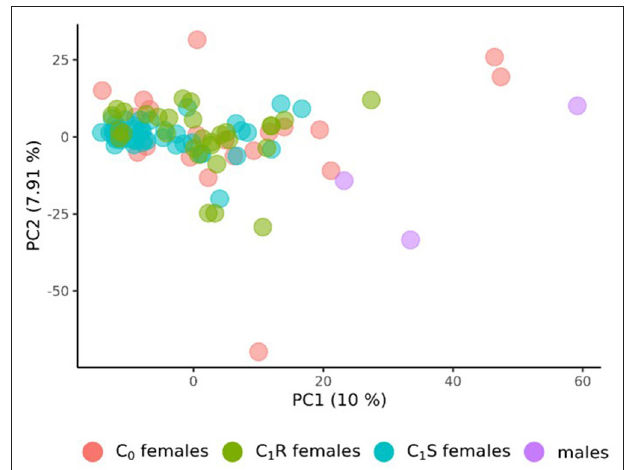
FIGURE 1 | Principal Component Analysis (PCA) of the 20 founder wheat lines (C 0 females), the 3 male lines, the 30 female lines drawn from random after recombining the 20 founder lines (C 1 R), and the 49 female lines from the first selection cycles (C 1 S). PCA were derived from the eigenvectors of the 3 male and 20 female founder lines. The proportion of variance displayed by the principal components (PC) were presented in